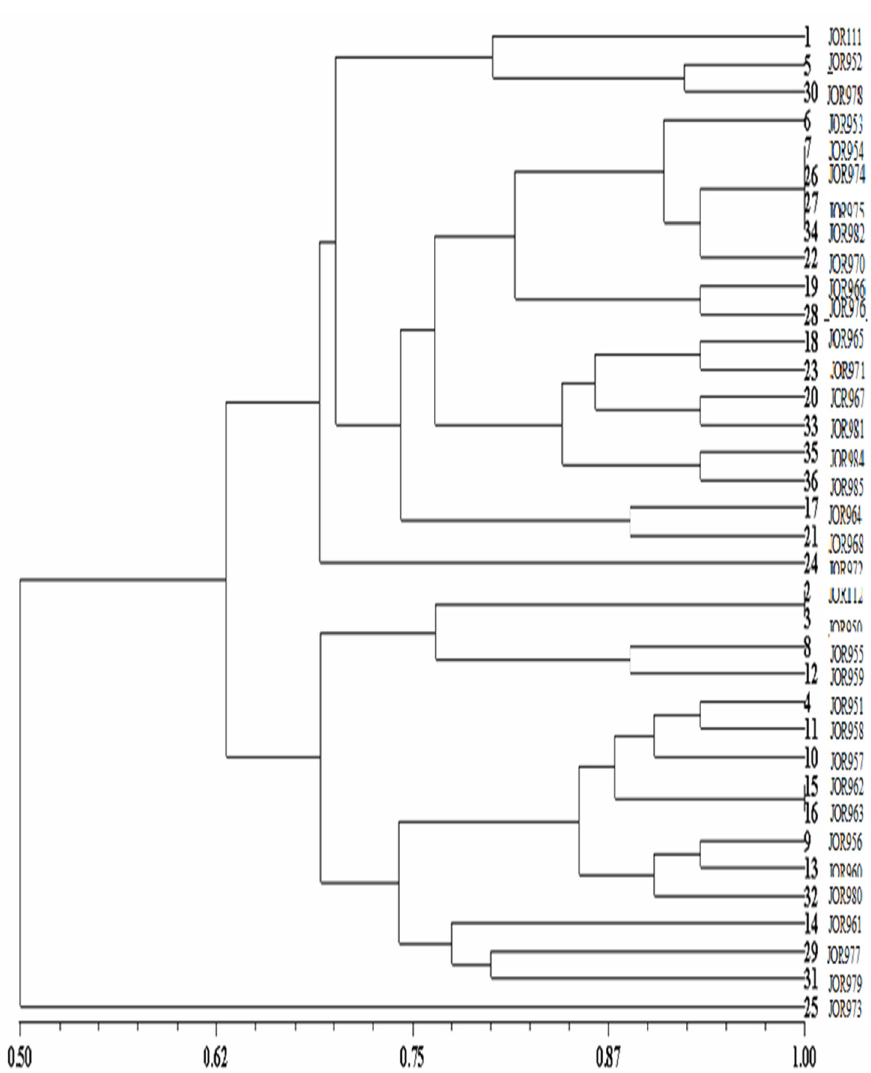
Figure 1. Dendrogram of tomato accessions generated by UPGMA cluster analysis of the dissimilarity values based on [ 45 ] coefficient.